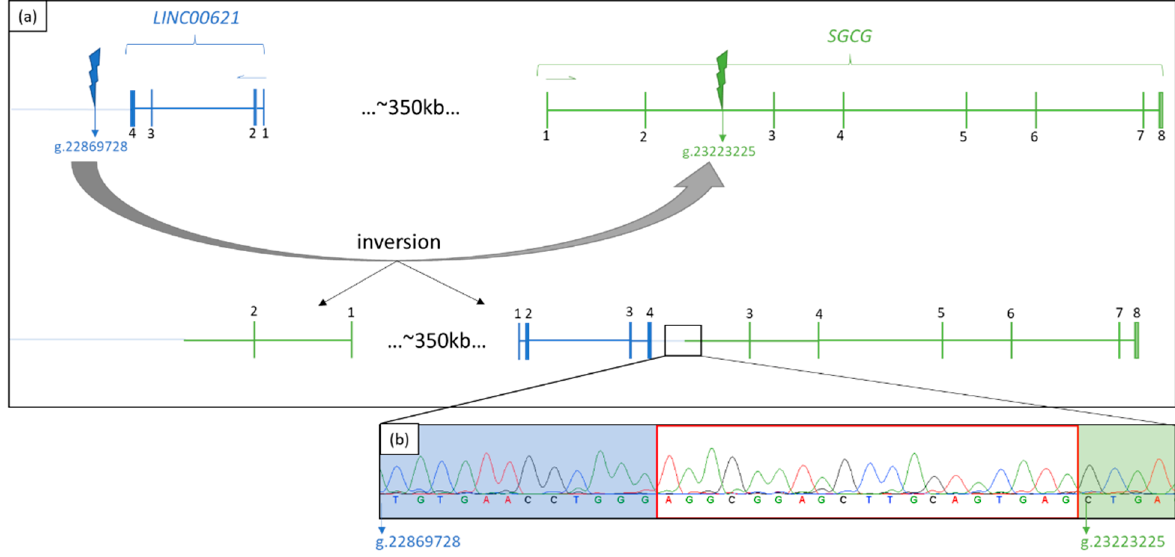
Figure 4. ( a ) Scheme of inversion. The exon numbering is listed in black numbers and the reading direction of the genes is indicated with a blue ( LINC00621 ) or green ( SGCG ) arrow. ( b ) Sanger sequencing of the fragment LINC00621 ‐ Upstream ‐ F and SGCG ‐ Int2 ‐ R. Marked in blue is the unique sequence of LINC00621 upstream and marked in green is the unique sequence of SGCG intron 2. The area in which the breakpoint can be located is outlined in red.